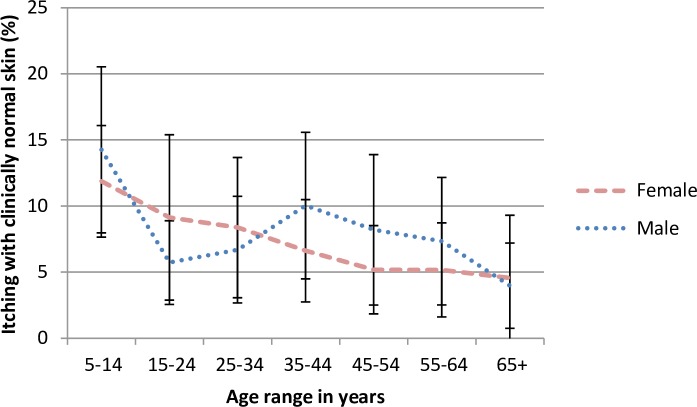
Age and gender-specific prevalence of itching with clinically normal skin in endemic savanna communities, Kaduna State, Northern Nigeria.Error bars represent mean and 95% CI.